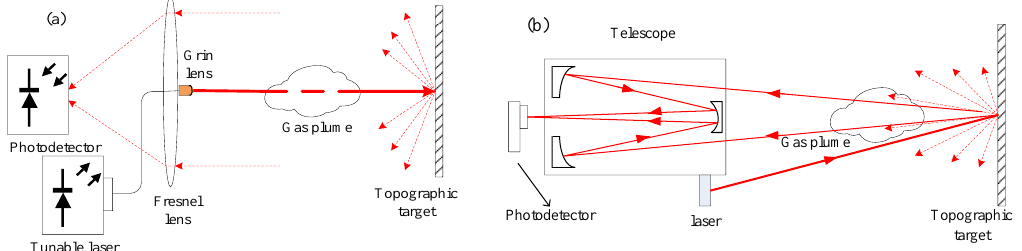
Figure 4. Typical transceiver units of the TDLAS system with the non-cooperative target ( a ) with a single Fresnel lens, and ( b ) with a large-aperture telescope.